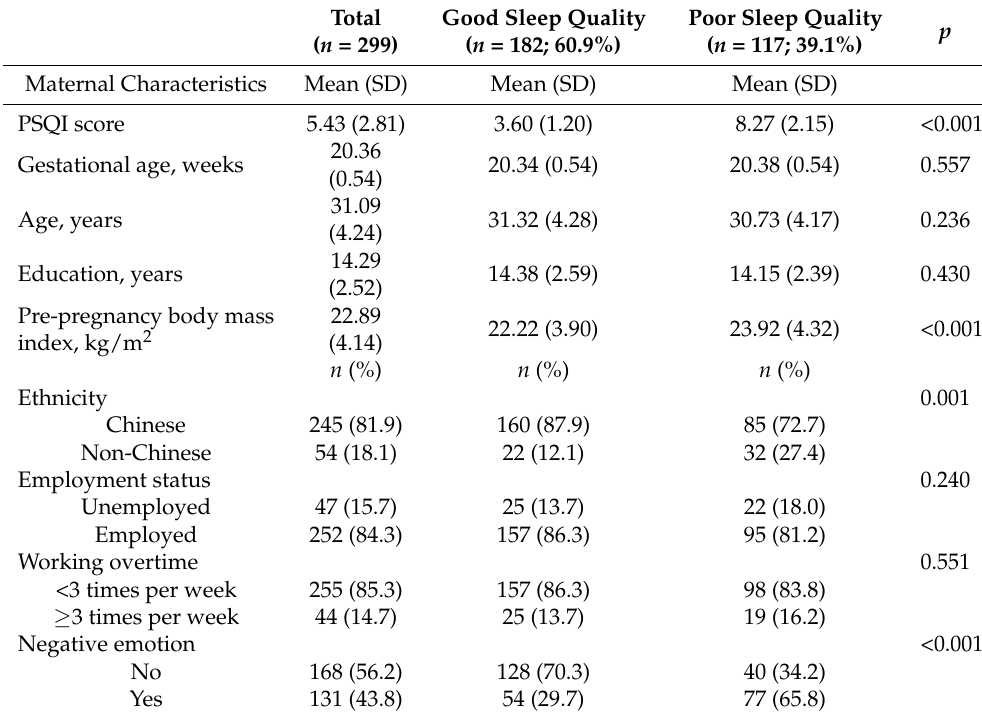
Table 1. Maternal characteristics during pregnancy.